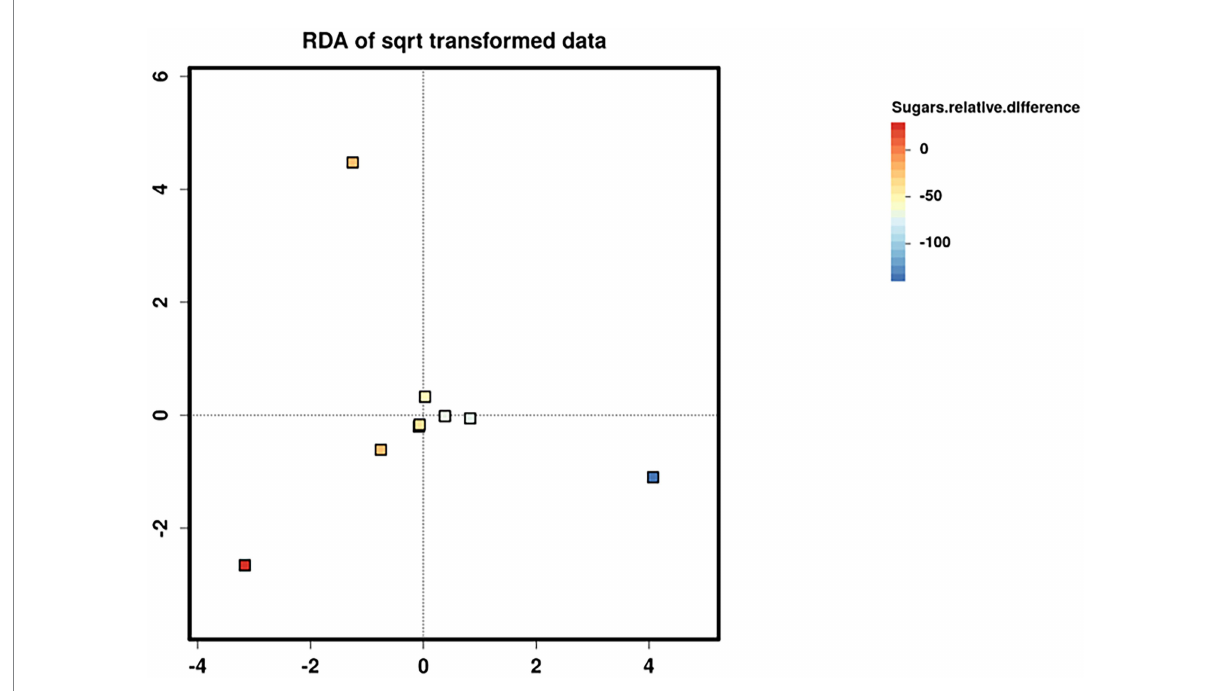
FIGURE 10 Redundancy analysis (RDA) biplots showing the two first axes of ordination for nine infant stool microbiome samples. Samples are coloured according to the change in maternal sugar intake with the dietary intervention.